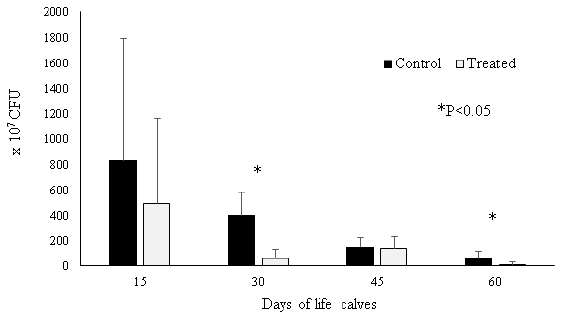
Figure 2 - total bacterial count in fecal samples of calves treated with a mixture containing components of essential oils. * P<0.05 in the same line indicates significant difference between